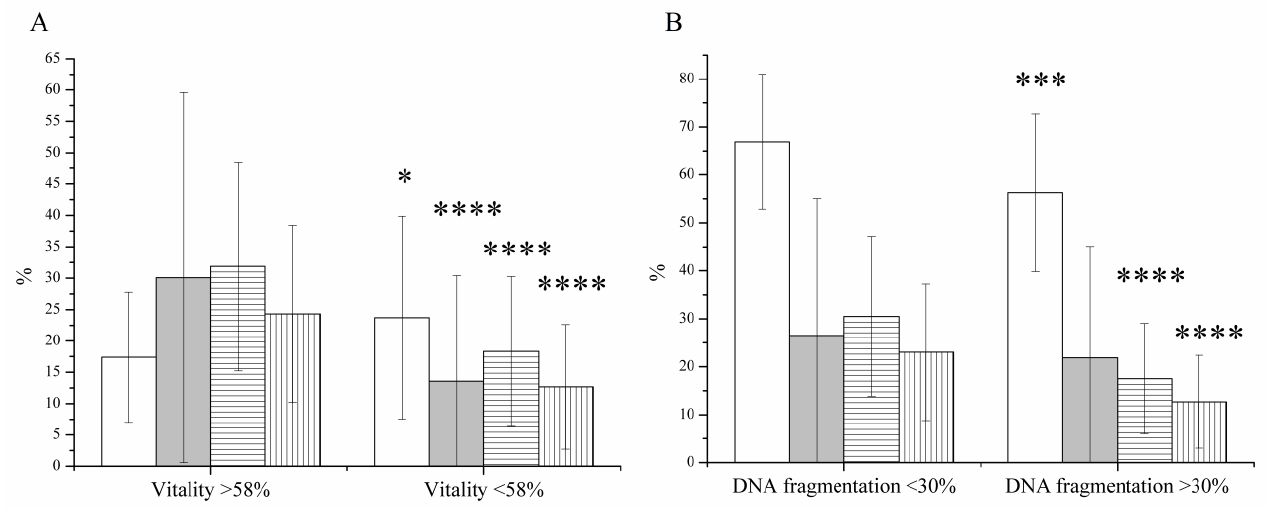
and 23.01 ± 14.23% vs. 12.68 ± 9.68%, respectively (Figure 1B).